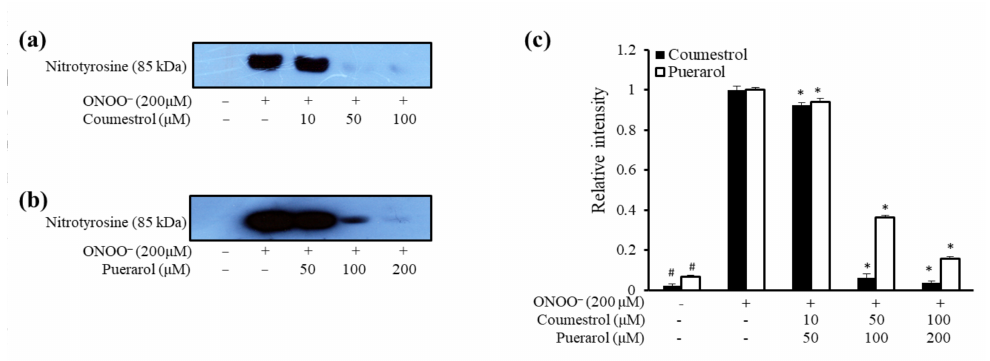
Figure 2. Dose-depended inhibition of ONOO − -mediated albumin nitration by coumestrol and puerarol. Mixtures of test samples, bovine serum albumin (BSA), and ONOO − were incubated with shaking at 37 ◦ C for 30 min. The reactant was resolved in 10% polyacrylamide gel via electrophoresis. ( a ) Coumestrol; and ( b ) puerarol, were used at the indicated concentrations; ( c ) Quantification of band intensity was calculated using CS Analyzer 3.00 (ATTO Corp., Tokyo, Japan). # p < 0.05 indicates